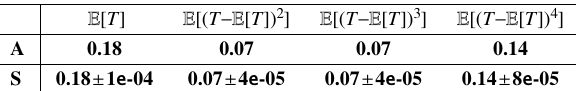
Table 6: Class 2 response time moments from GRID